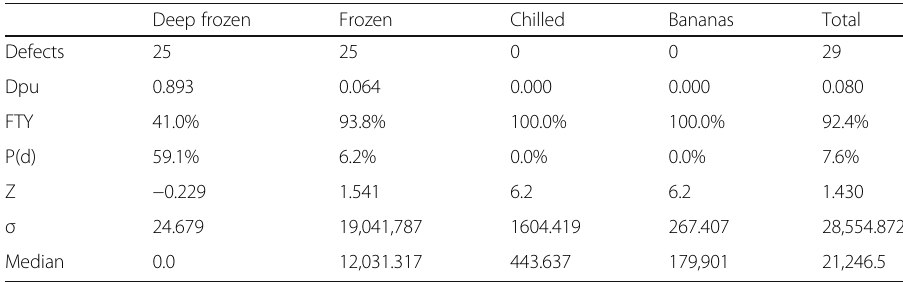
Table 5 Energy performance Deep